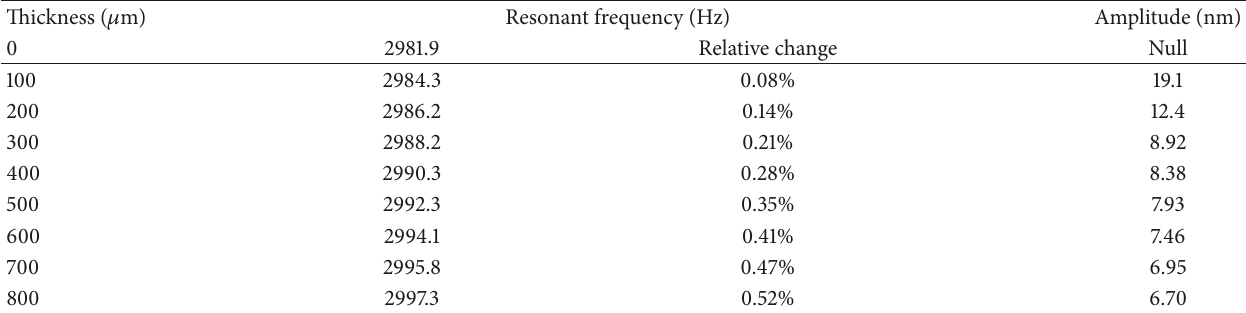
Table 3: The simulation results of resonant frequencies and vibrational amplitudes under different thicknesses of piezoelectrodes.